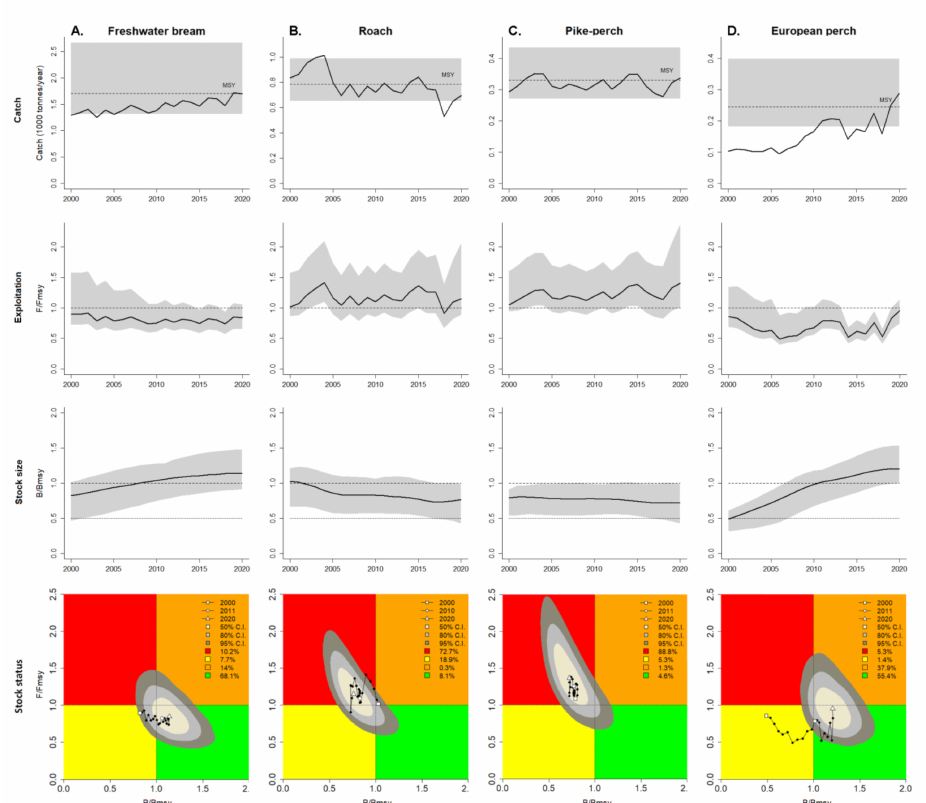
Figure 5. The graphs of CMSY analysis to inform management ( A ) of Freshwater bream, ( B ) of Roach, ( C ) of pike-perch, and ( D ) of European